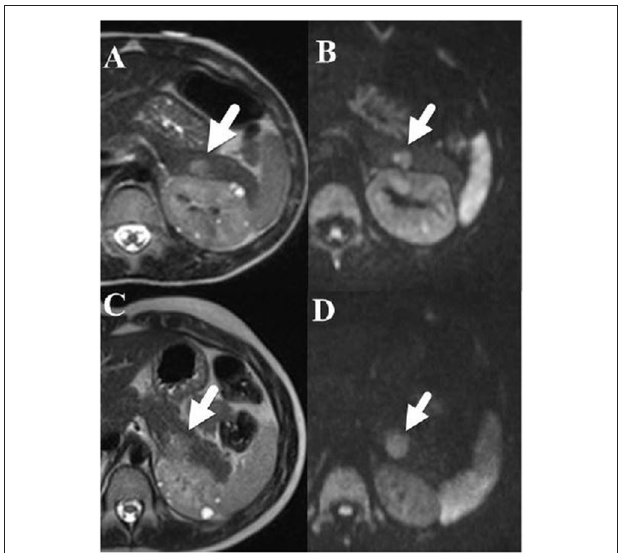
FIGURE 3 | (A) [Upper left] Axial T2-weighted fast spin echo and (B) [Upper right] diffusion weighted MRI images performed in a 6-year-old boy show a 1.2 × 0.8cm hyperintense mass (arrow) in the tail of the pancreas that restricts diffusion. Note that small cysts are also present within the left kidney. (C) [Lower left] an Axial T2-weighted fast spin echo and (D) [Lower right] diffusion weighted MRI images performed 3 years later show that the pancreatic tail mass (arrow) has grown slowly and now measures 1.4 × 1.5cm.